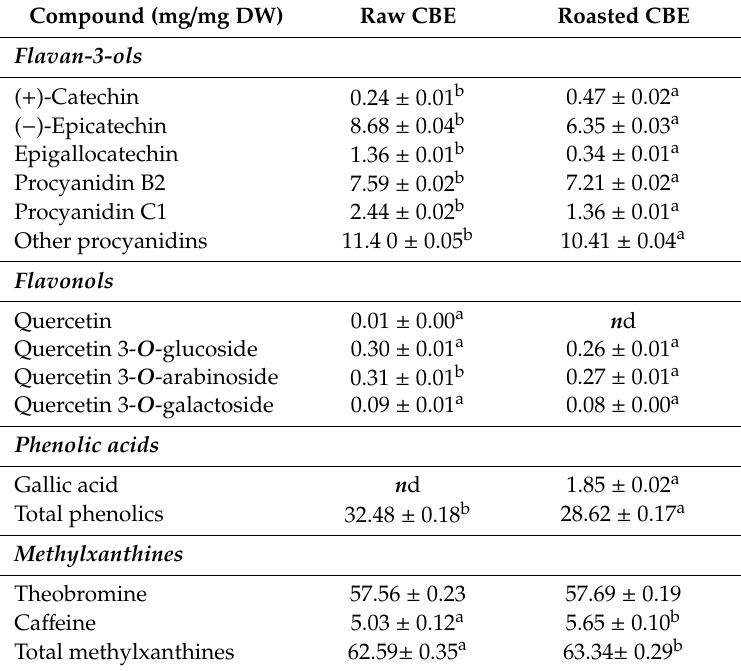
Table 1. Composition of cocoa bean